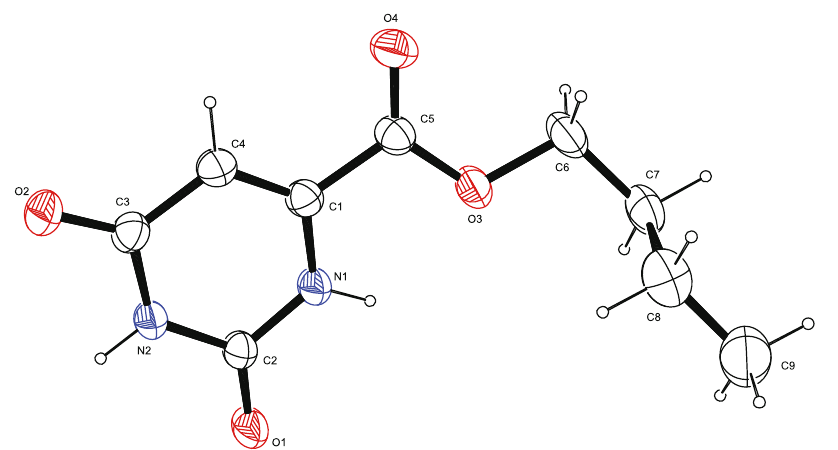
Figure 2: Crystal structure of compound 3 .